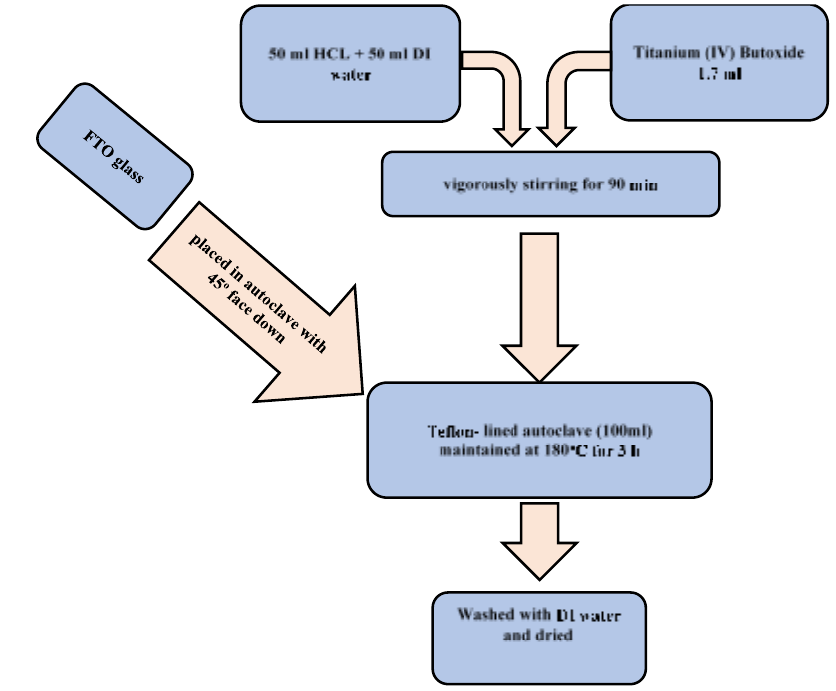
Figure 2: Illustrate the flowchart of experimental